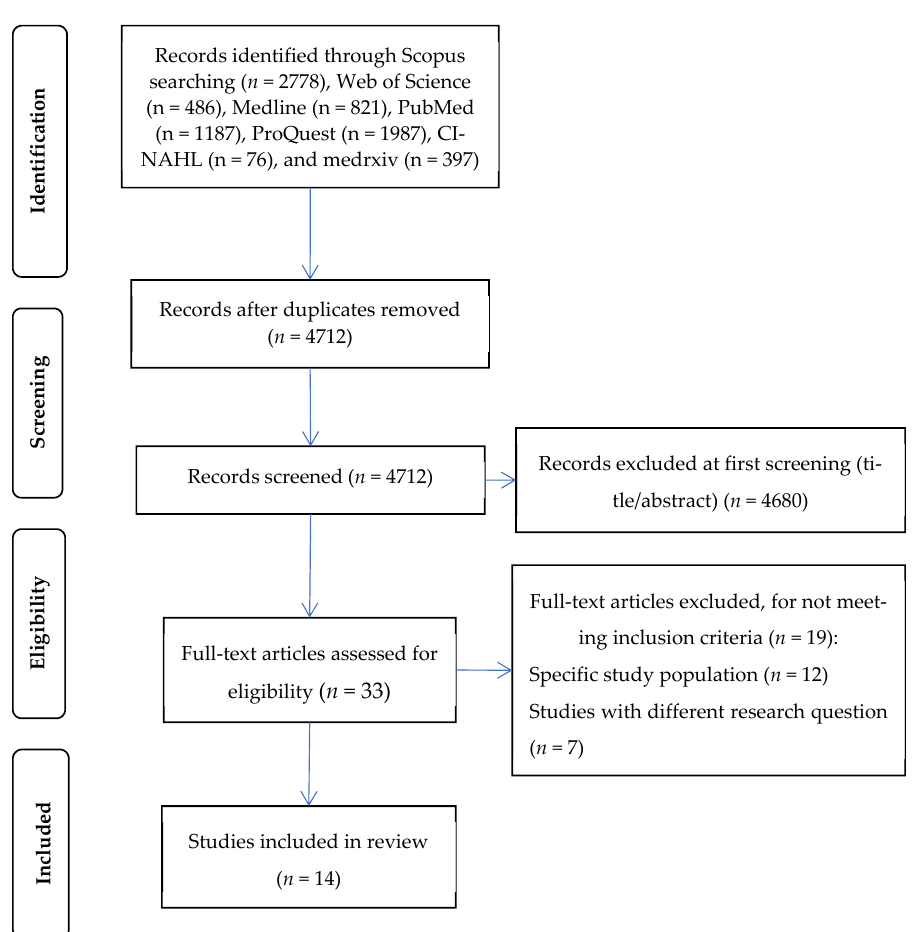
Figure 1. Flowchart of the literature search according to the Preferred Reporting Items for Systematic Reviews and Meta-Analysis.